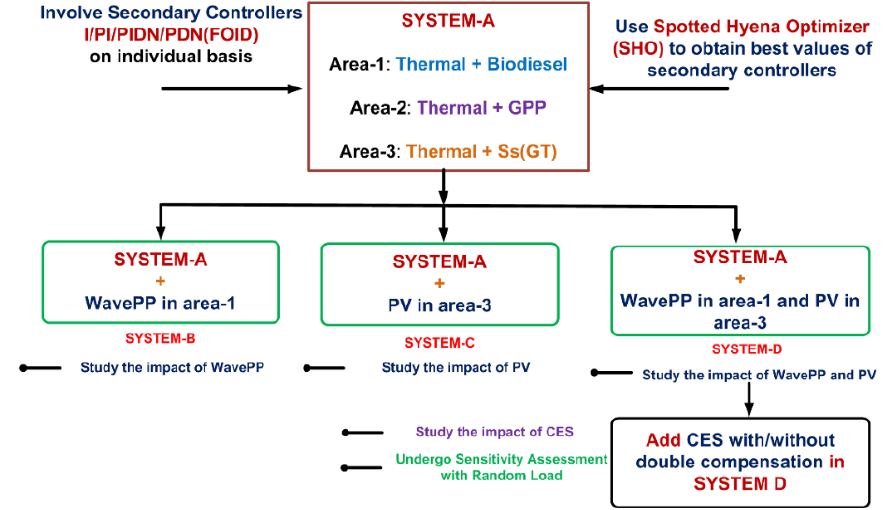
Figure 1. Schematic representation of the entire work.